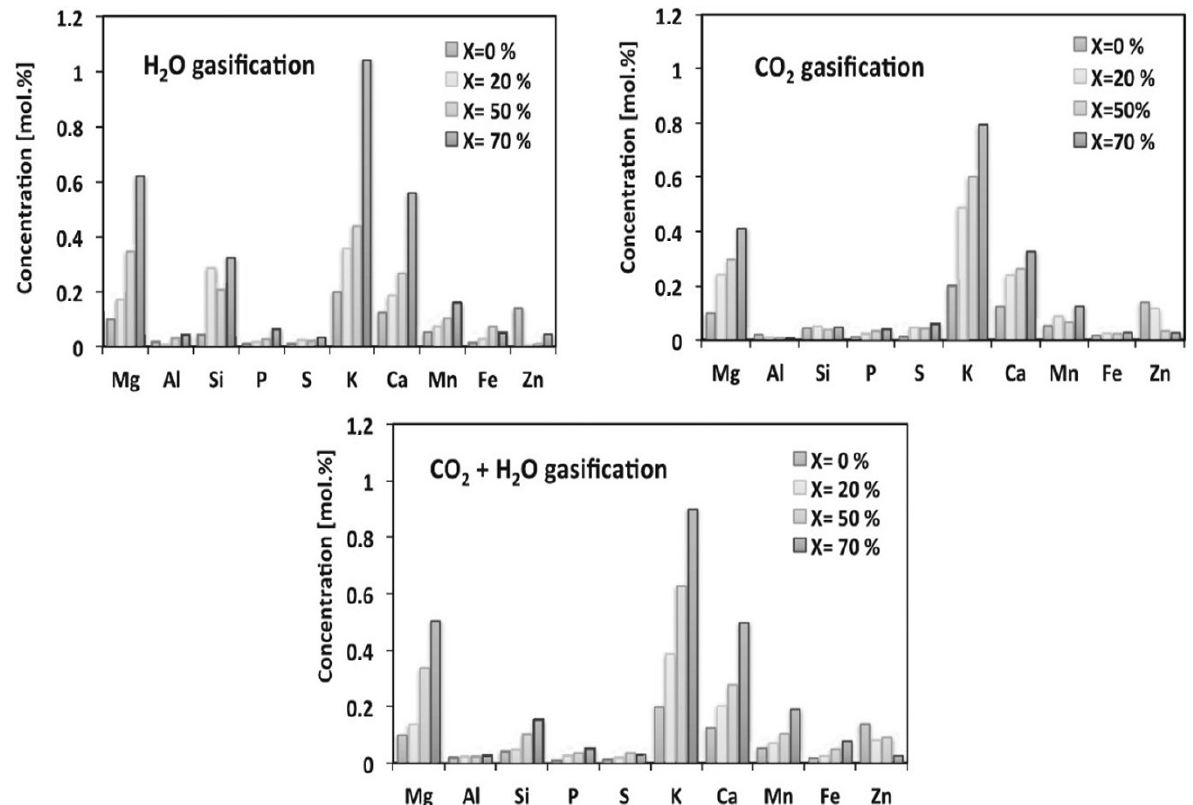
Figure 4. Concentration of inorganic components in the beechwood char (mol.%) along the gasifi-